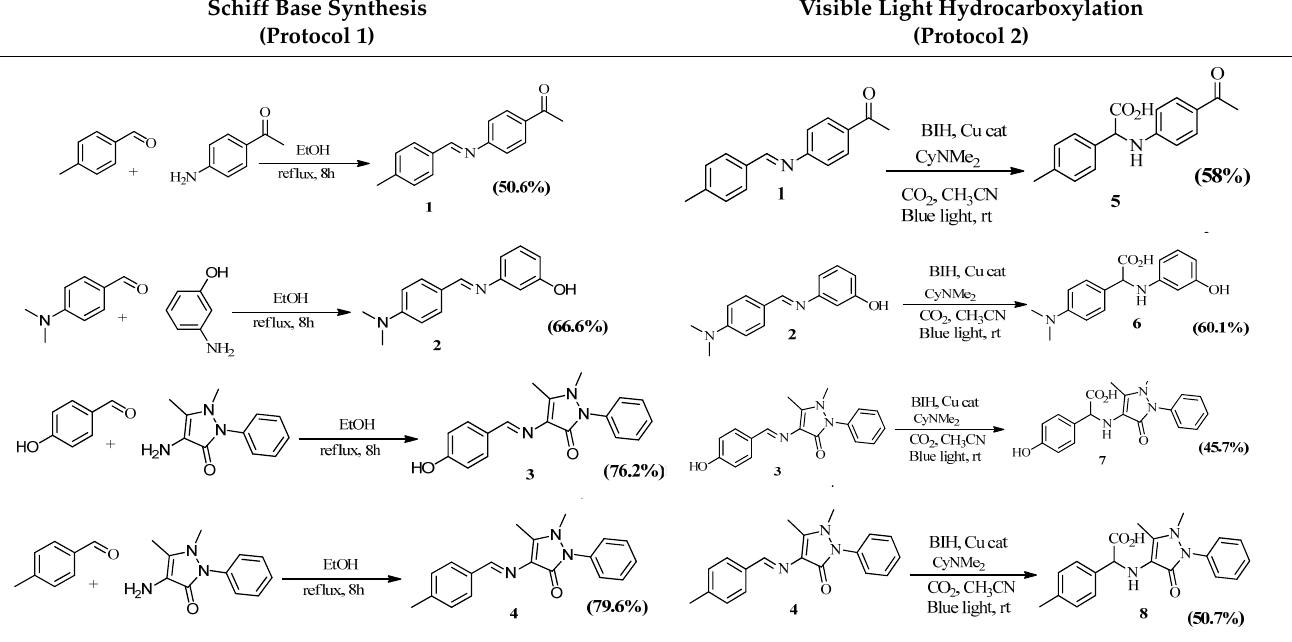
Table 4. Schiff base synthesis and desired hydrocarboxylation products.